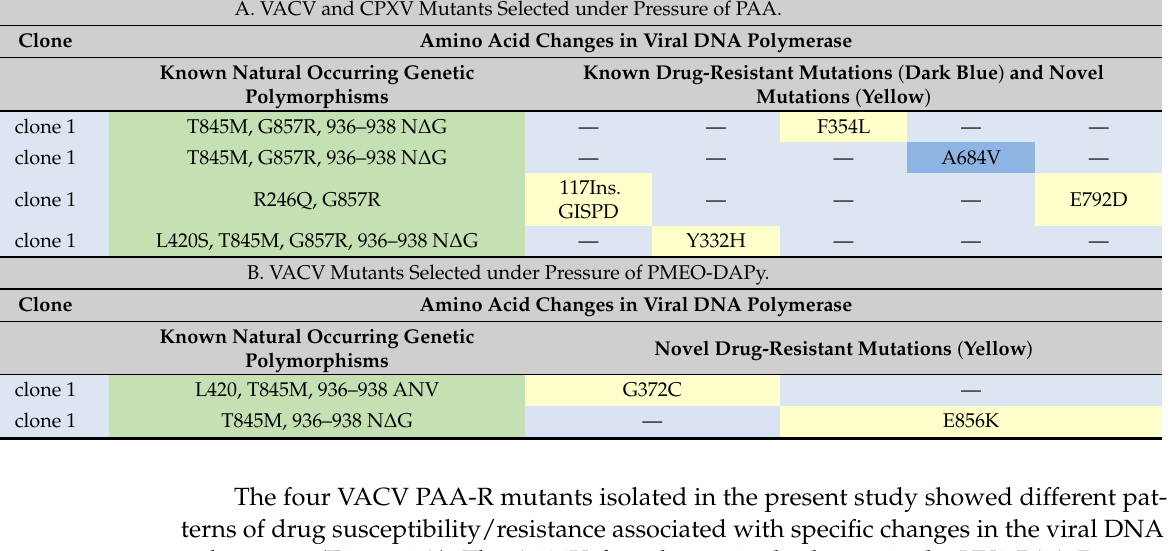
Table 4. Identification of amino acid changes in the viral DNA polymerase following selective pressure with the pyrophosphate analogue phosphonoacetic acid (PAA) (A) or the acyclic nucleoside phosphonate PMEO-DAPy